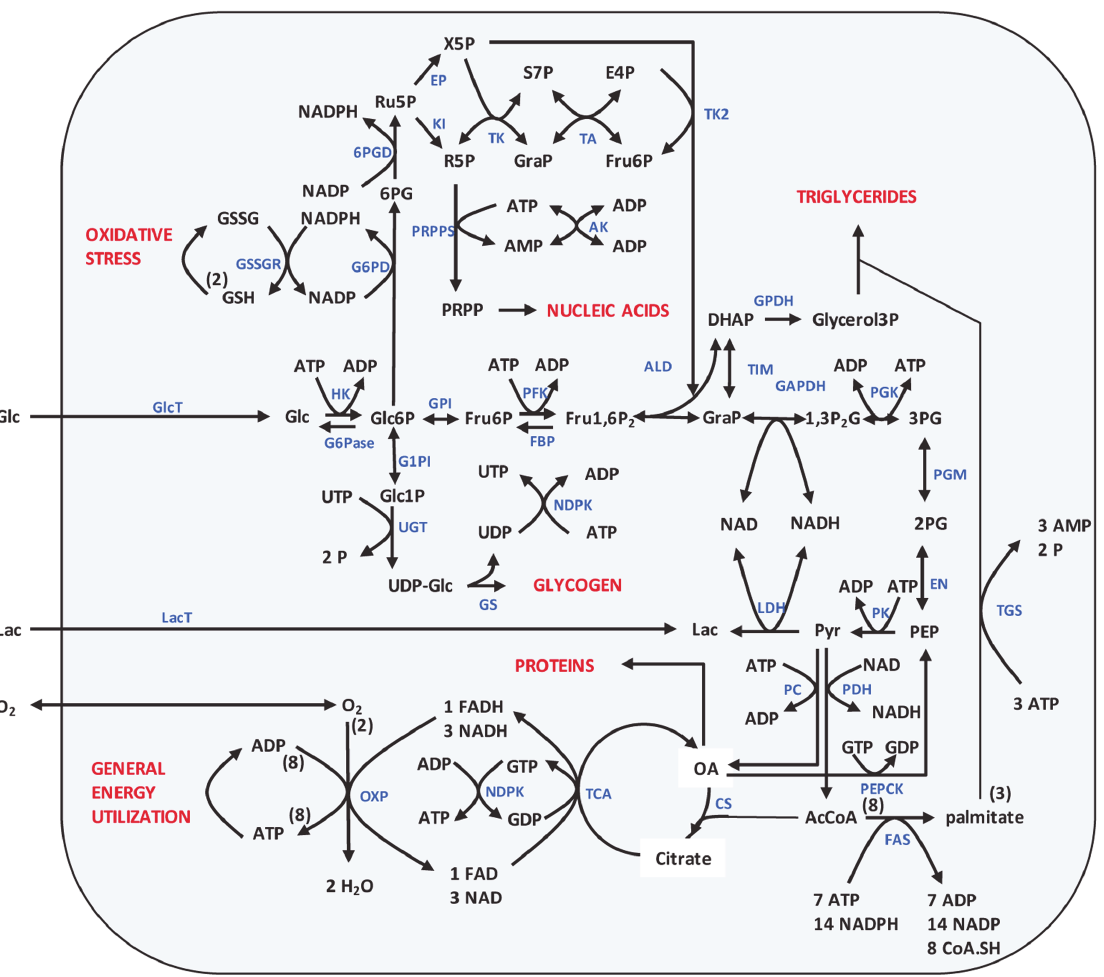
Fig 3. Scheme of the network of the central carbon metabolism, with glucose or lactate as substrates. The metabolic output, i.e., production of triglycerides, nucleic acids, proteins and glycogen are shown in red as well as the permanent energy consumption (ATPase) and oxidative stress (GSHox). Names of all reactions can be looked up in supplemental S1 Table. The metabolites are Lactate (Lac), Glucose (Glc), Glucose-6- P (Glc6P), Fructose-6- P (Fru6P), Fructose-1, 6-bisphosphate (Fru1, 6P2), Glucose-1- P (Glc1P), UDP-Glucose (UDP-Glc), Dihydroxyacetone phosphate (DHAP),